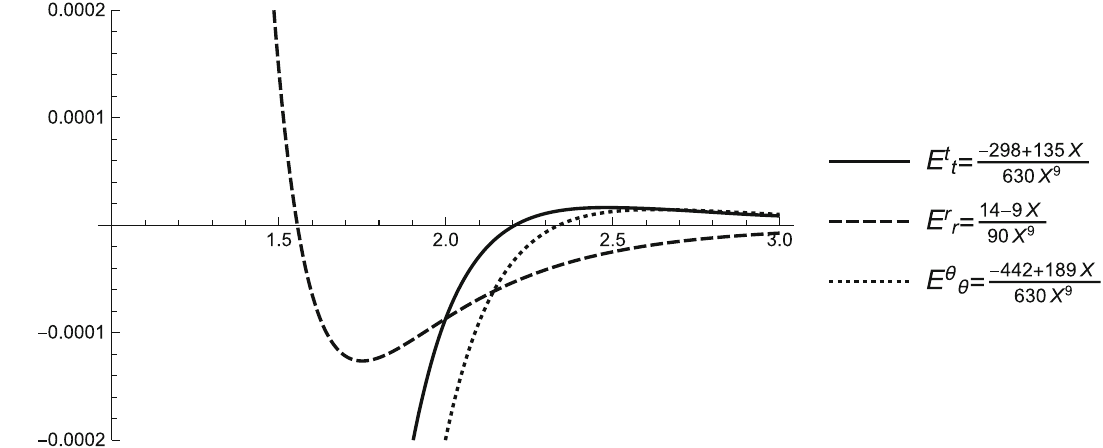
Fig. 1 Various components of the energy-momentum tensor of matter source (or effectively of the LHS of the EOM) for a Schwarzschild ansatz as functions of the dimensionless radial coordinate X . For preparation of the plots we used an identification 8 μ 3 M 3